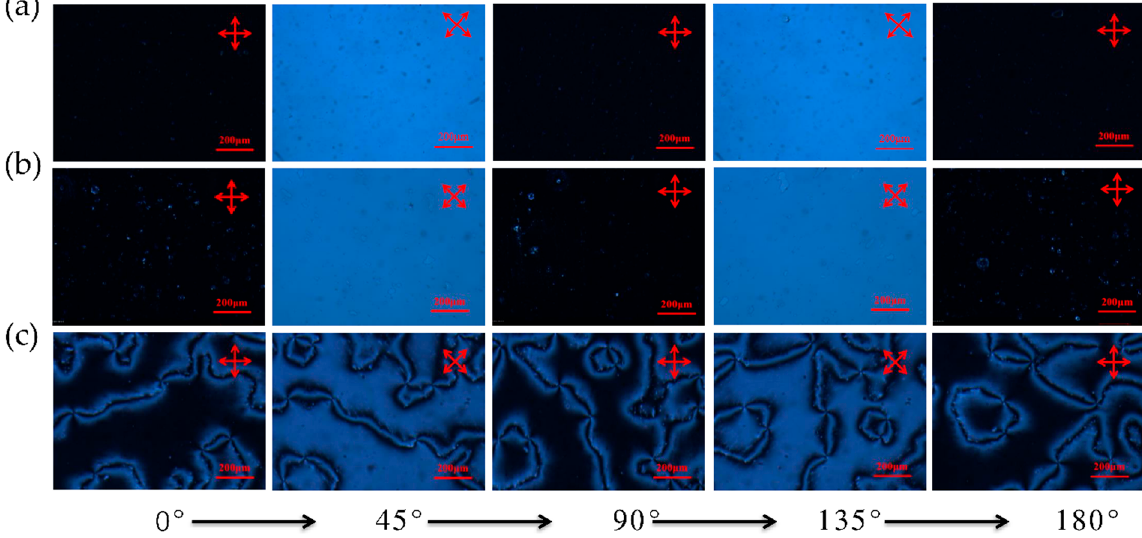
Figure 1. POM images of the cell with different alignment layers: ( a ) PVA–PVA; ( b ) PVA–PVK; ( c ) PVK–PVK.